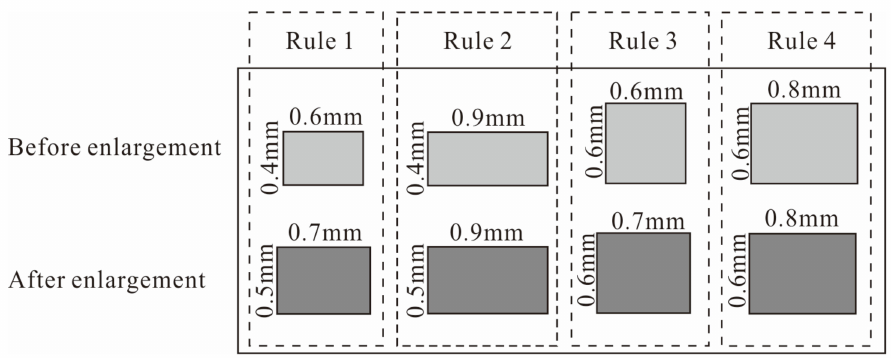
Figure 7. Building